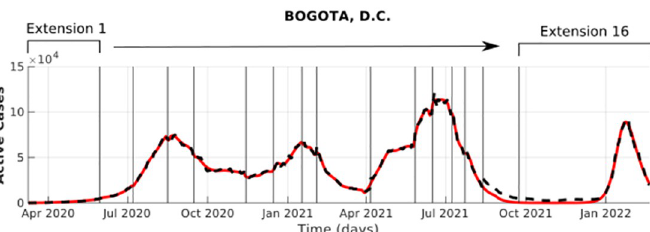
Fig 6. Bogota´ fitting for active cases. The vertical lines represent the dates when we stopped using a set of parameters and estimated a new set using the method described in section 2.3 and S1 Appendix. The most representative abrupt changes in the time series are related to social behavior o changes in public policies, e.g., in Bogota´, the first, second and third extensions are related to the gradual relaxation in lockdown policies; the sixth, seventh and eighth extensions are related to increases in interactions and migrations within the population because of vacations and Christmas celebration; the ninth and tenth extensions correspond to an increase in migration because of Easter vacation, and so